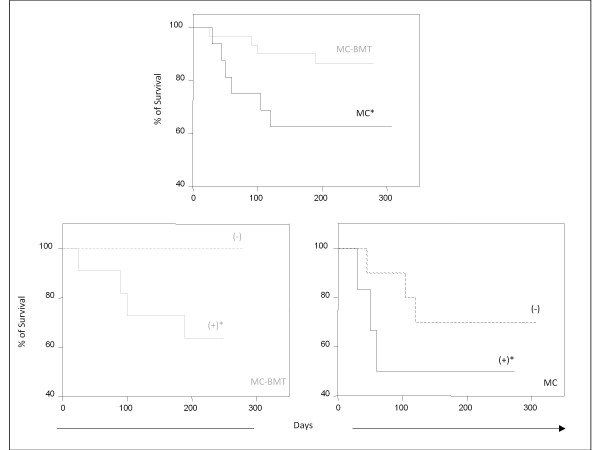
Survival rates of animals with canine mammary carcinoma. Kaplan-Meier survival curves for animals from MC-BMT or MC (top panel), further subcategorized according to the absence (-) or presence (+) of lymph node metastasis (-) (bottom panels). Animals were submitted to quarterly follow-ups during twelve months and survival rates (%) expressed in days between the surgical excisions of the end of follow-up as described in Methods. The survival curves were estimated with the Kaplan-Meier method followed by Log-rank test and significant differences at p < 0.05 highlighted by asterisk.